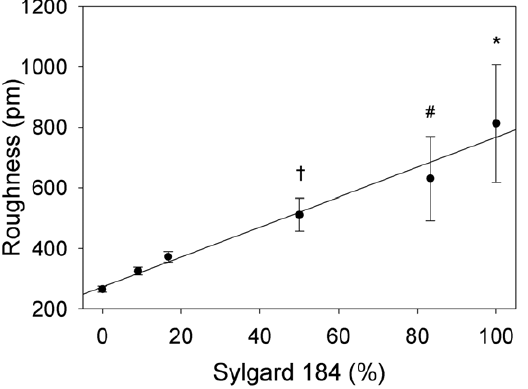
Figure 4. Water contact angle of uncoated and collagen IV coated PDMS formulations. The water contact angles of all uncoated PDMS formulations (black) are approximately 110 u , indicating a similar surface energy and hydrophobicity. The water contact angles of all PDMS formulations decreases to approximately 100 u when coated with collagen type IV (gray), indicating similar protein adsorption behavior and surface energy. All uncoated PDMS formulations were relatively hydrophobic thought to be indistinguishable to cells despite the small, but statistically significant differences in water contact angle between the 5 kPa versus the 1.72 MPa, 130 kPa and 50 kPa substrates ( # indicates p , 0.05). All collagen type IV coated PDMS formulations were statistically equivalent and had statistically significant decreases in water contact angle compared to the uncoated PDMS (*indicates p , 0.05). Data represented as mean 6 standard deviation, statistical significance based on two-way ANOVA with Holm-Sidak pairwise comparison